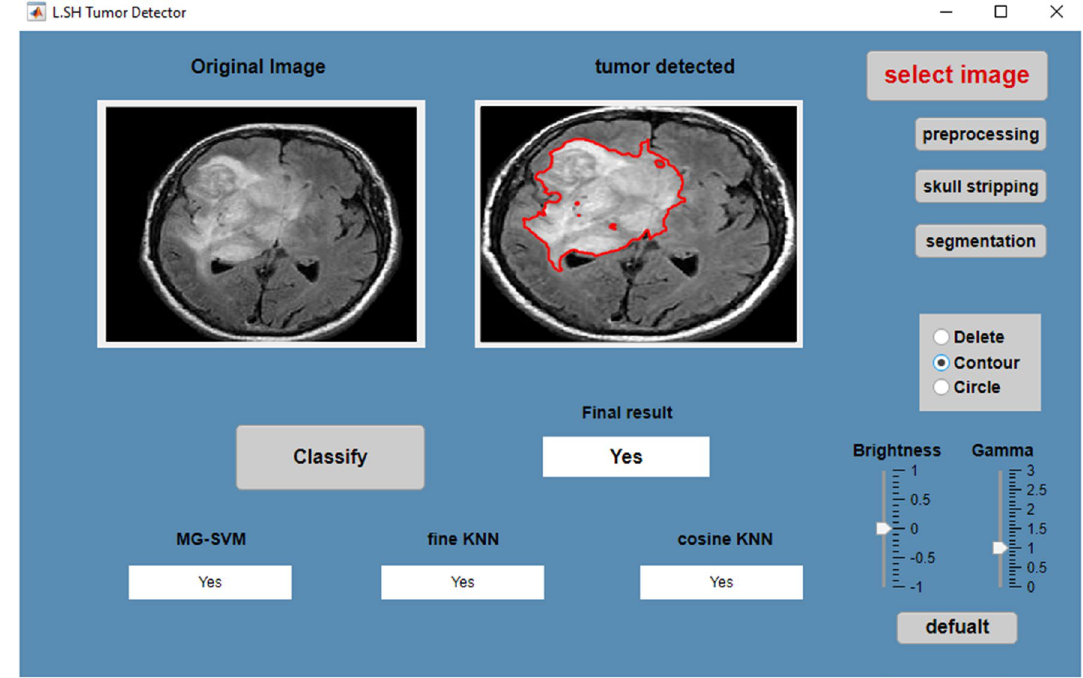
Fig. 6 The graphical user interface (GUI)